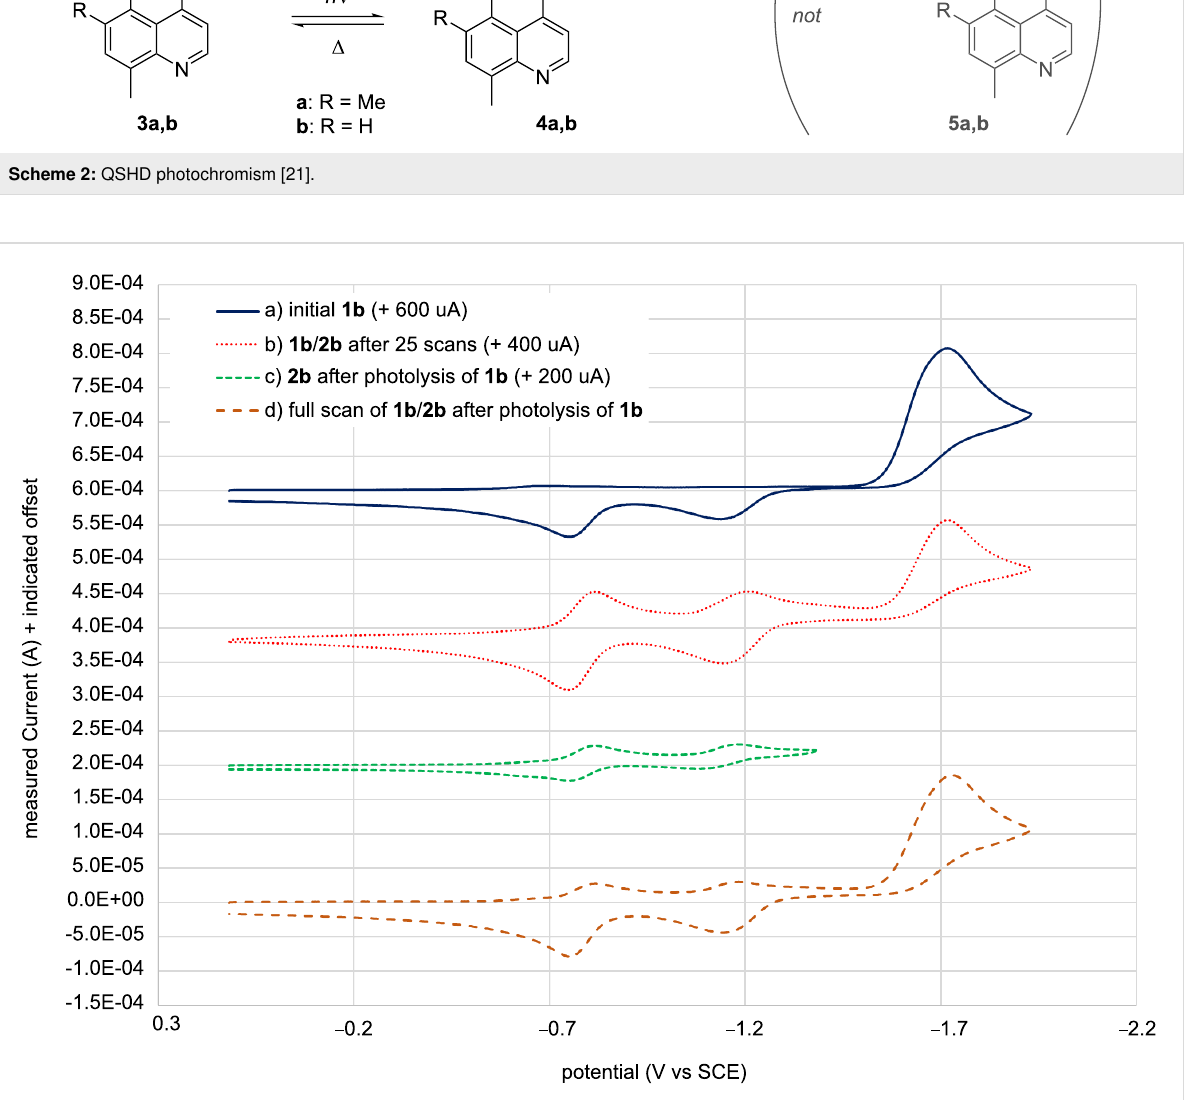
Figure 2: Cyclic voltammograms of a) 1b before irradiation or electrolysis (solid blue), b) 1b/2b after 25 scans (dotted red), c) 1b/2b upon photolysis of 1b (dashed green) scanned over a narrower potential window so as not to reduce 1b , and d) 1b/2b scanning the full potential window after photoly- sis of 1b (dashed